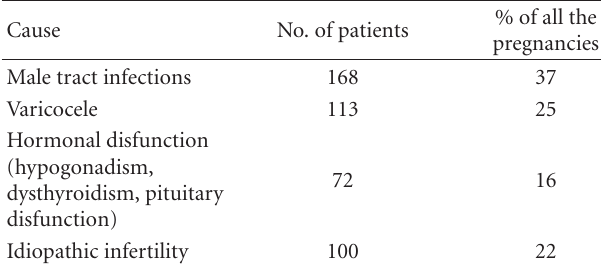
Table 2: Causes of male